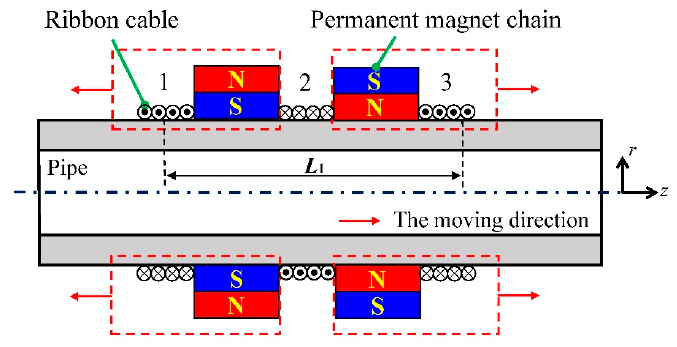
Figure 16. Schematic diagram of the method for the interval adjustment.